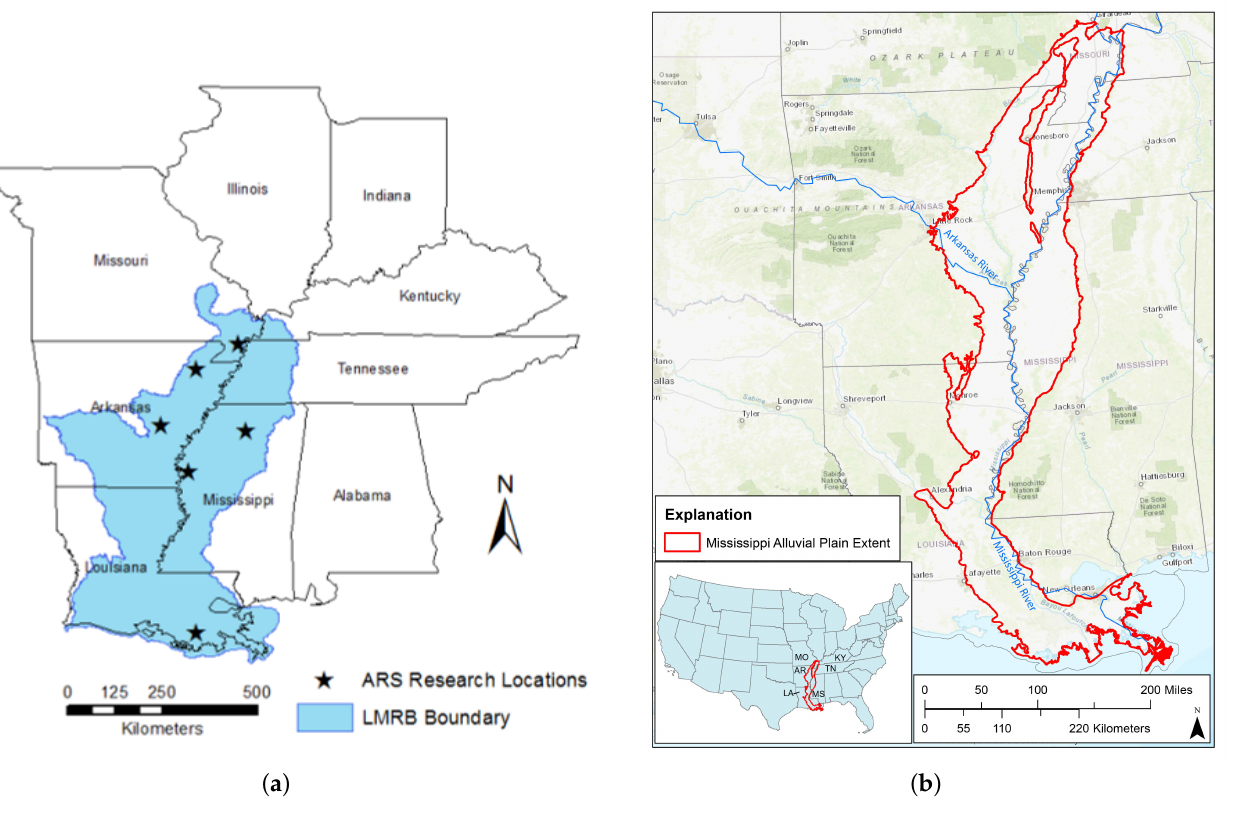
Figure 1. Sources: ( a ) from https://www.ars.usda.gov/southeast-area/oxford-ms/national- sedimentation-laboratory/water-quality-and-ecology-research/docs/lmrb-ltar/ (accessed on 30 September 2022), ( b ) U.S. Geological Survey. ( a ) USDA Agricultural Research Service sites in the Lower Mississippi River Basin (LRMB). ( b ) Location and extension of the Mississippi River Valley Alluvial Aquifer